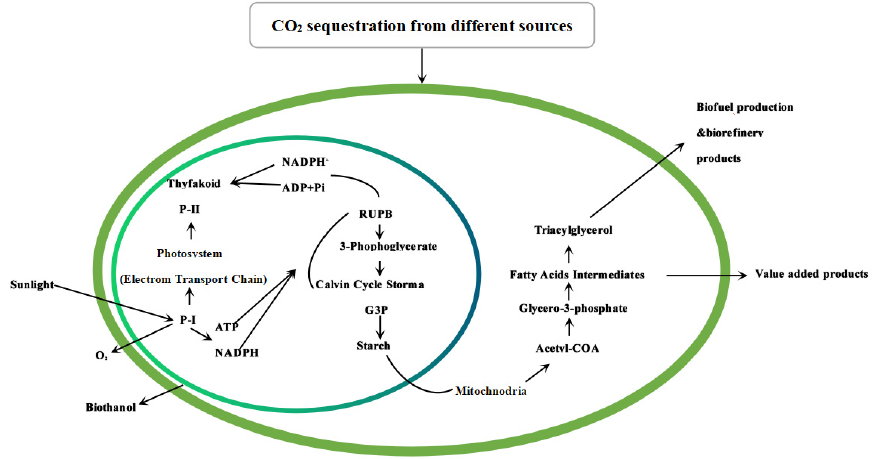
Figure 4. A schematic mechanism of macroalgae to fix CO 2 and produce bioenergy.